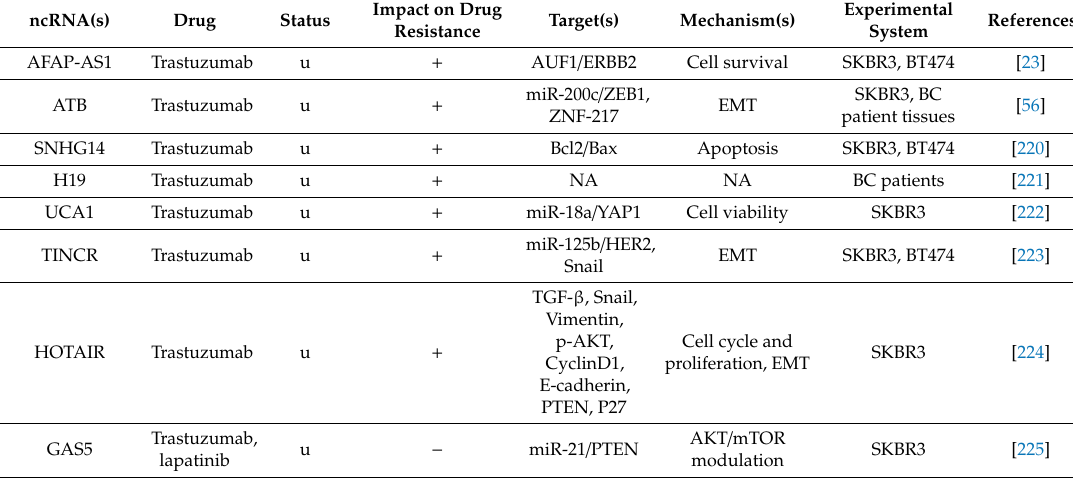
Table 5. lncRNAs in anti-HER2 drug resistance 1 ; (u) upregulated; (d) downregulated; ( + ) increase; ( − )